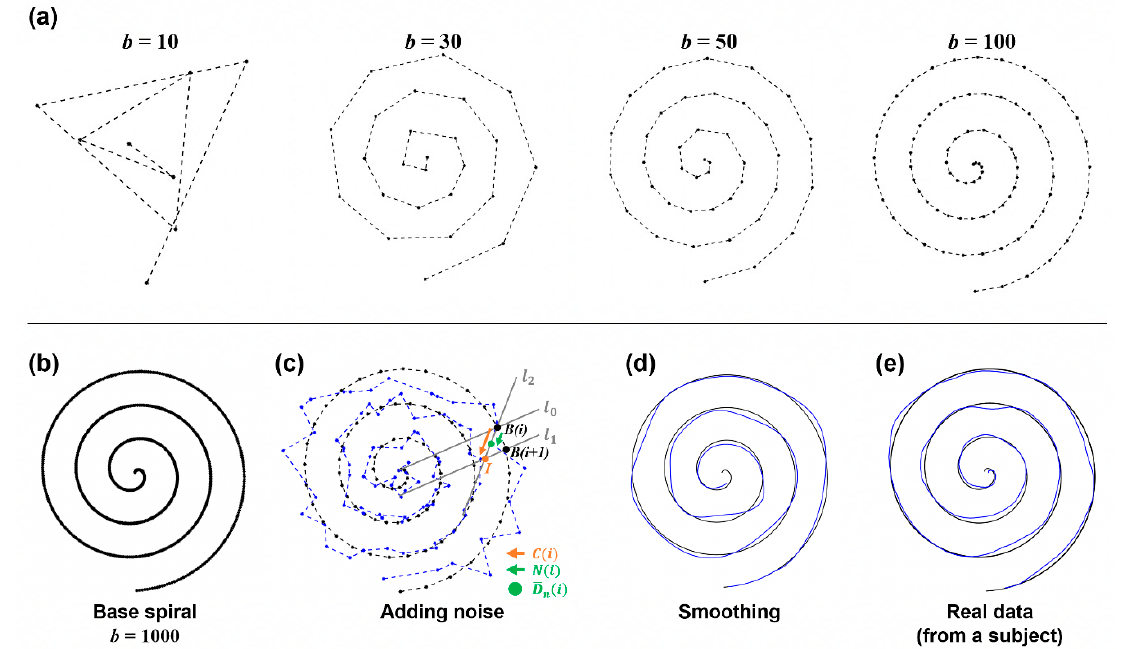
Figure 3. Principles and process of simulation data. ( a ) The base spiral generation at a different number of points. ( b ) Base spiral at 𝑏 = 1000 that is used in this study. ( c ) Illustration of adding noise. At 𝐵(𝑖) , 𝑁(𝑖) with a noise level 𝐿 was chosen and added to 𝐵(𝑖) . ( d ) The result after smoothing. ( e ) For comparison, the real data acquired from a representative subject are shown.